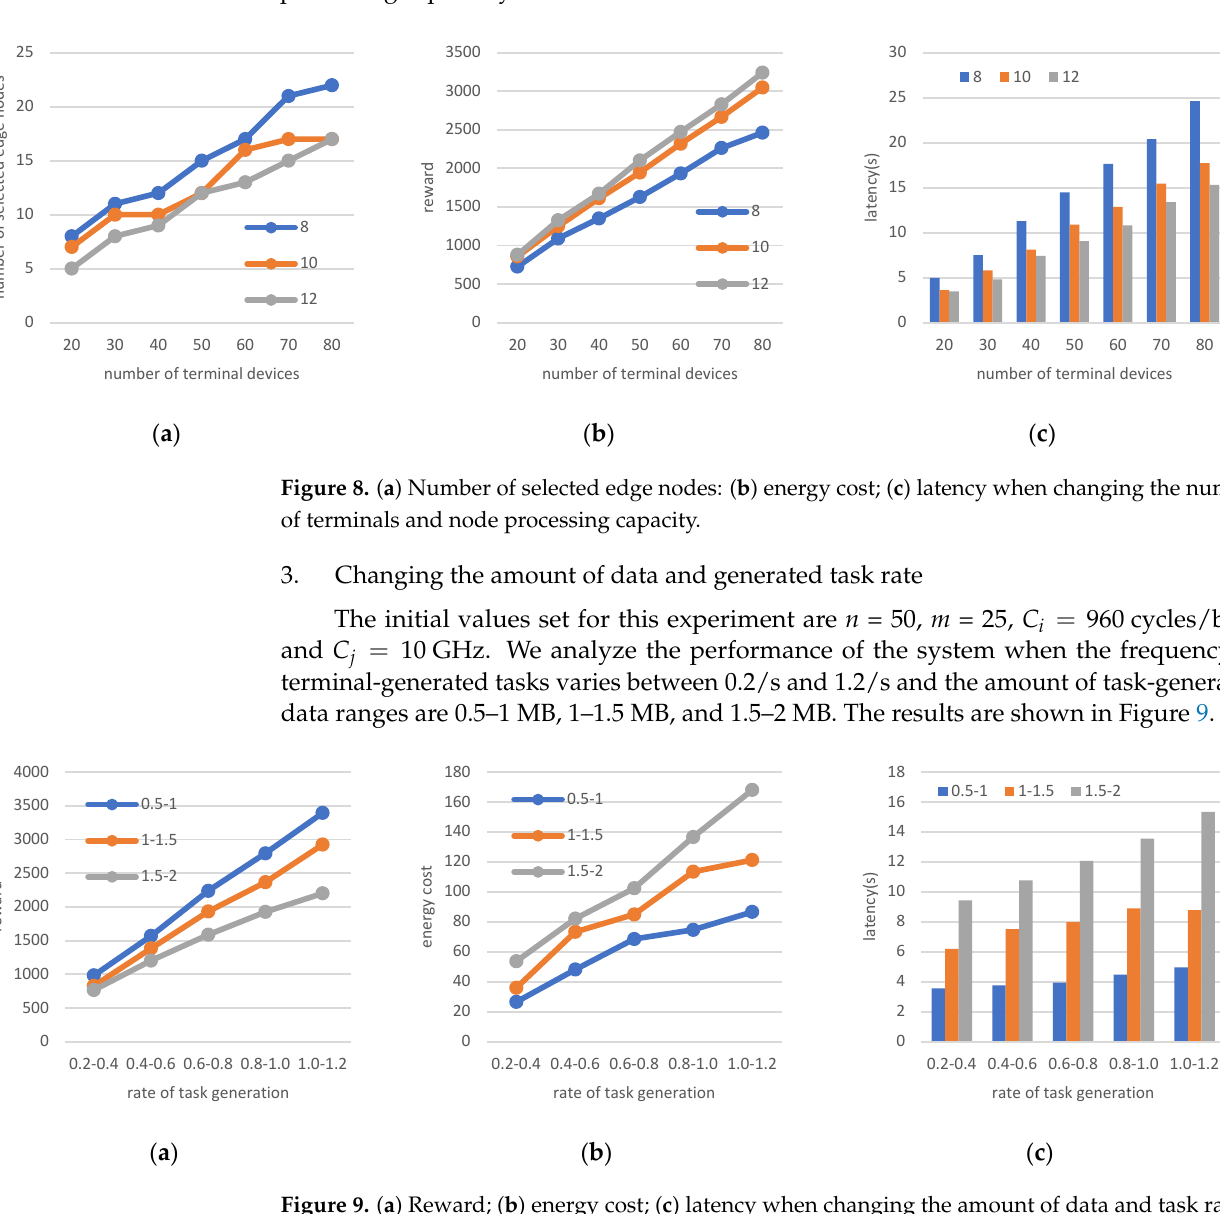
The initial values set for this experiment are n = 50, m = 25, C = . We analyze the performance of the system when the frequency of and 10GHz j terminal-generated tasks varies between 0.2/s and 1.2/s and the amount of task-generated data ranges are 0.5–1 MB, 1–1.5 MB, and 1.5–2 MB. The results are shown in Figure 9. Figure 9. ( a ) Reward; ( b ) energy cost; ( c ) latency when changing the amount of data and task rate. With a constant range of data generated by the task, the higher the frequency of the task generated by the terminals, the more energy consumed to meet the demand of the transmission, as shown in Figure 9b. For the data range of 1.5–2 MB, the1.0–1.2/s rate increases energy consumption by 1.13 times compared to the 0.2–0.4/s rate. The latency increases in Figure 9c, and the obtained reward value increases, as shown in Figure 9a, with an increased rate of task generation. As shown in Figure 9a, for tasks in the range of 1.5–2 MB (the gray line), the 1.0–1.2 MB/s rate increases the reward value by a factor of 1.87 compared to a rate of 0.2–0.4 MB/s. When the generated data ranges from 0.5–1 MB to 1.5–2 MB, the time required for transmission increases and affects the reward value function, as shown by the blue line passing through the yellow line to the gray line in Figure 9a, indicating a decrease in the reward value, suggesting that the limitations of the transmission require that the end task be generated in such a way that the amount of data transmitted is compressed as much as possible to obtain an improved reward value for the tasks while satisfying all the information requirements for the calculation. 4. Changing task complexity and edge node processing capability; The initial values set for this experiment are n = 50 and m = 25, with the data volume of the terminal task in the range of 1–1.5 MB, and a task-generated rate of 0.8/s. The performance and parameters of the system are analyzed when the processing complexity of the terminal-generated tasks are 330, 960, 1300, and 1900 and the processing performance of the potential edge nodes is 8 GHz, 10 GHz, and 12 GHz. The obtained experimental results are shown in Figure 10. ( a ) ( b ) ( c ) Figure 10. ( a ) Number of selected edge nodes; ( b ) reward; ( c ) latency when changing the task complexity and edge node processing capability.